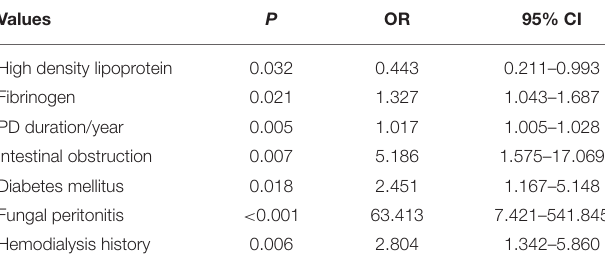
TABLE 3 | Multivariate logistic regression model on prediction of the peritonitis treatment failure.